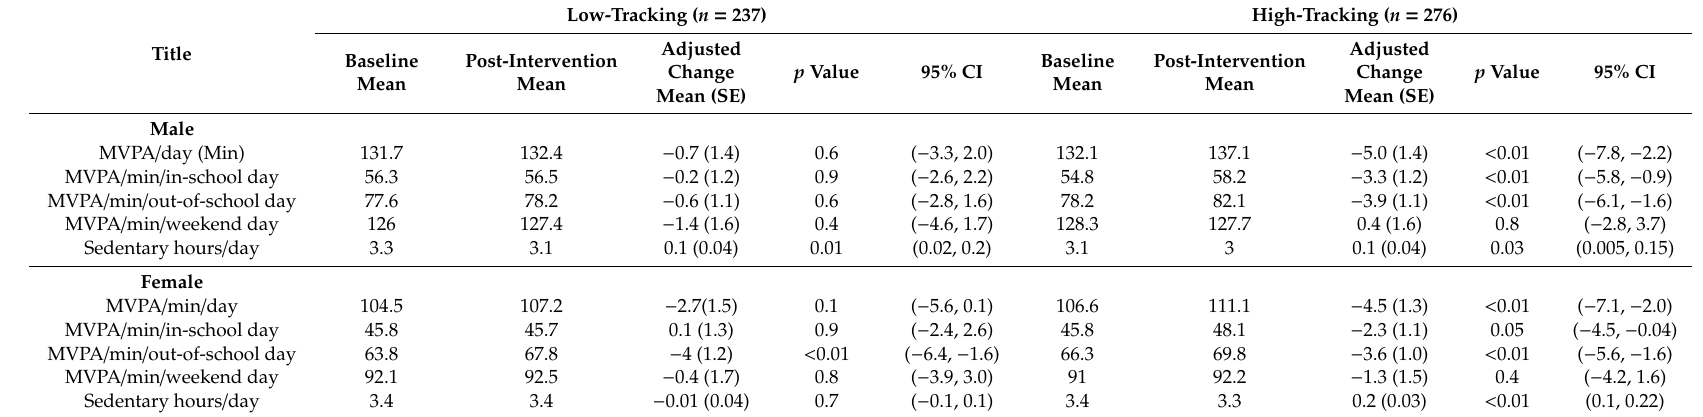
Table 1. Least square mean estimates by tracking, gender and